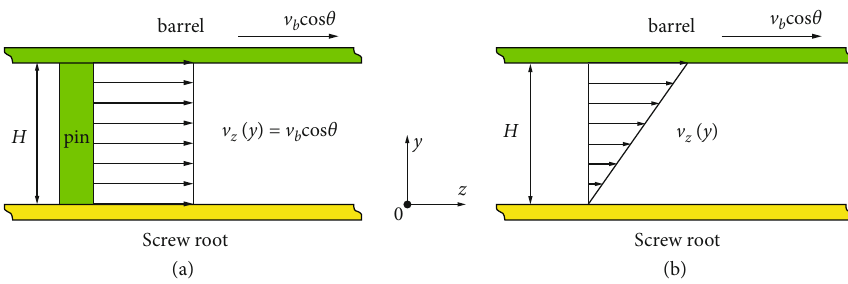
Figure 3: Velocity pro fi les. H is the depth of the screw channel. (a) Pin velocity in the z direction. (b) Fluid z direction velocity in the screw channel area without